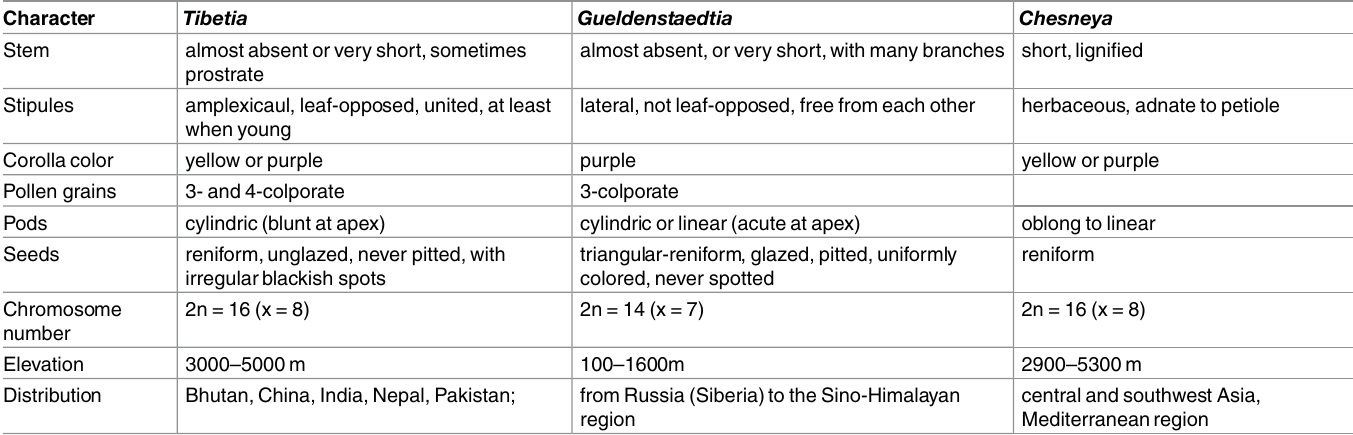
Table 1. Morphological,cytological and ecological differences among Tibetia and Gueldenstaedtia s.str. and Chesneya (Fabaceae).